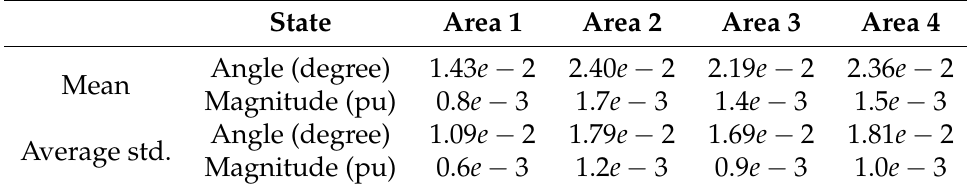
Table 1. Statistic metric per state per area on IEEE -14.